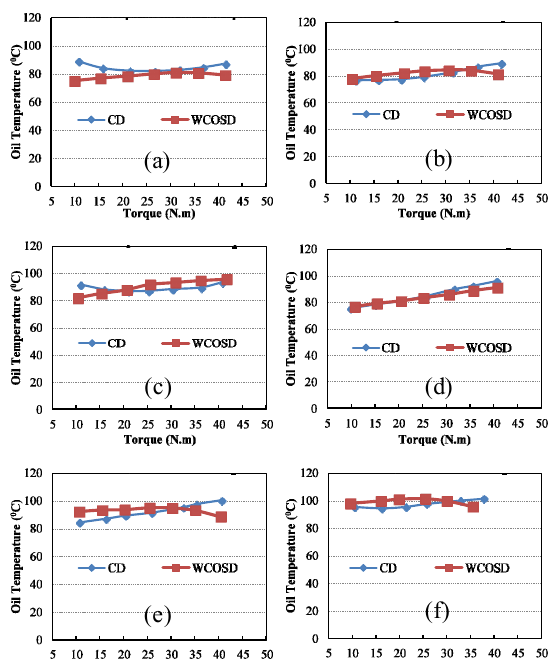
Figure 6. Lubricant oil temperatures at partials load and di ff erent engine speeds: ( a ) at 1200 rpm,